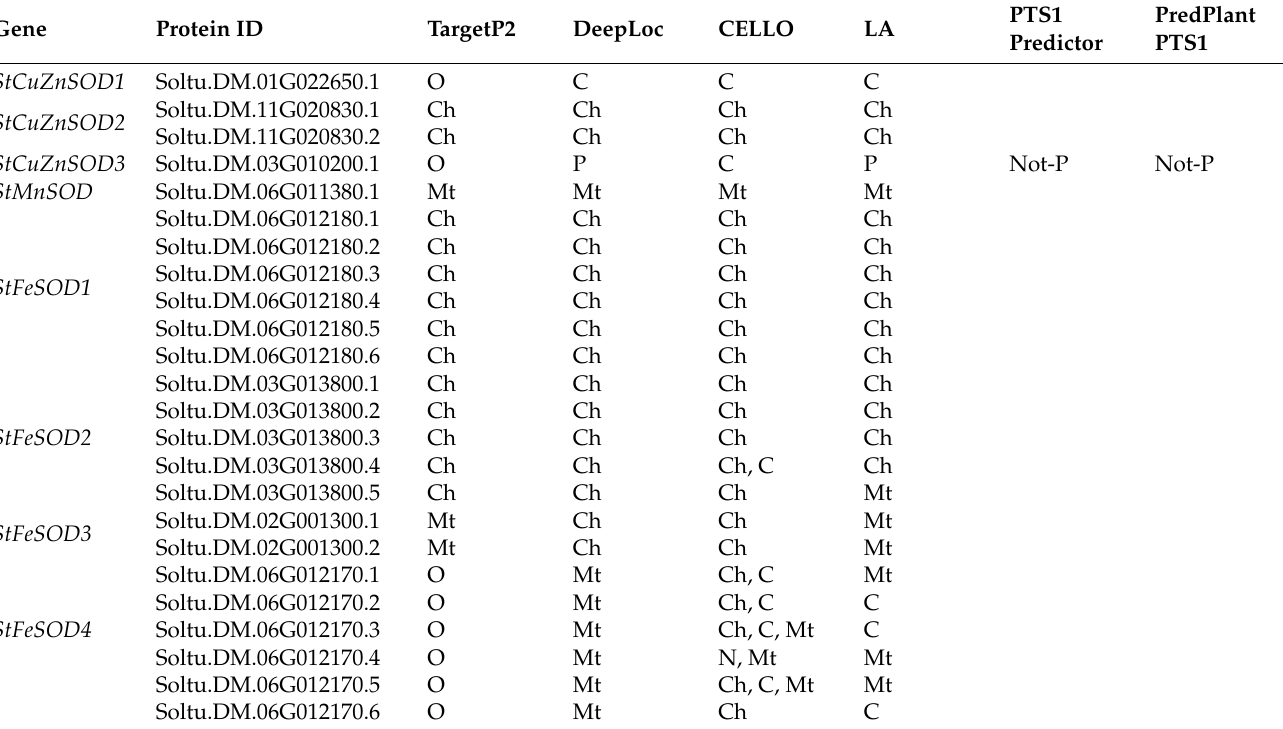
Table 2. Comparative subcellular localization prediction of potato SODs by different